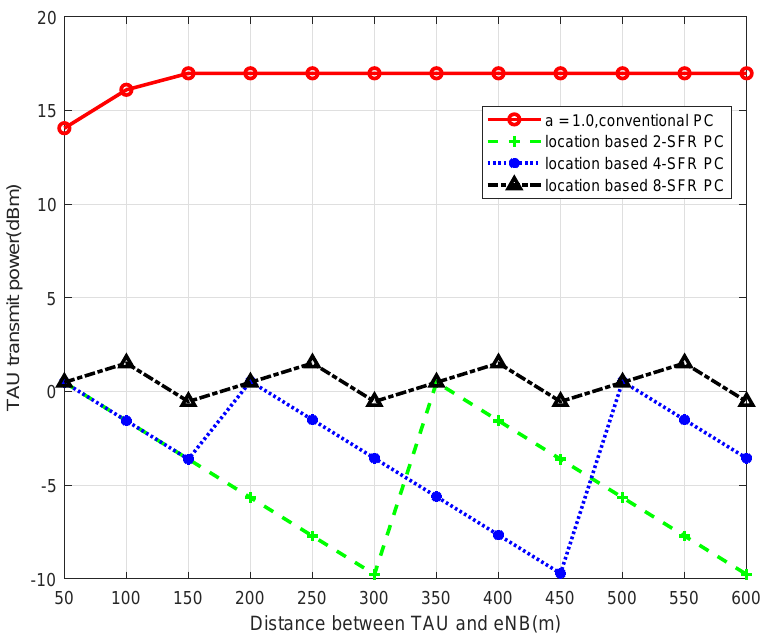
Figure 7. Transmit power with the traditional power